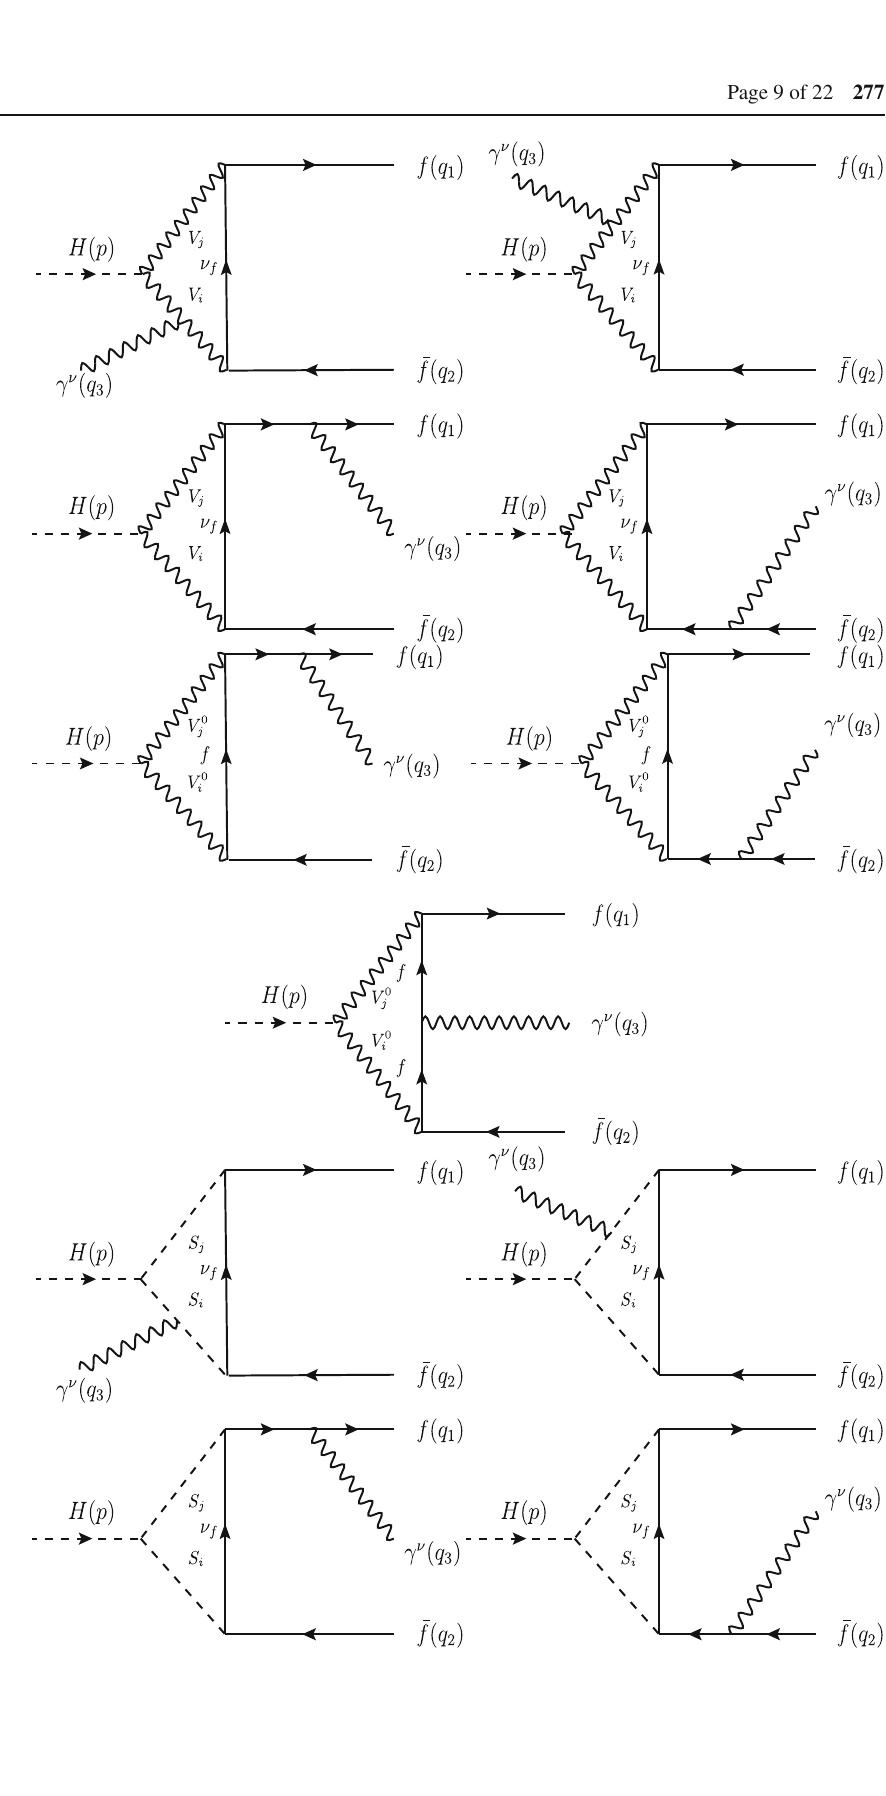
Fig. 9 One-loop diagrams with charged scalar bosons S i , j in the